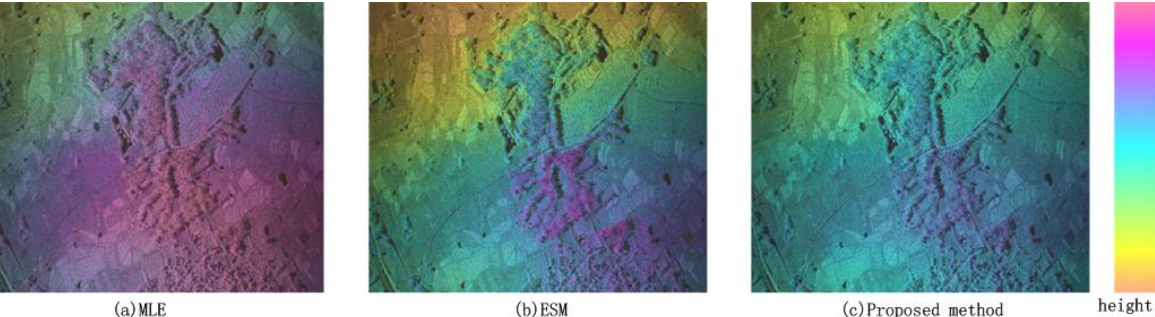
Figure.9. DSM mapping results using three methods.